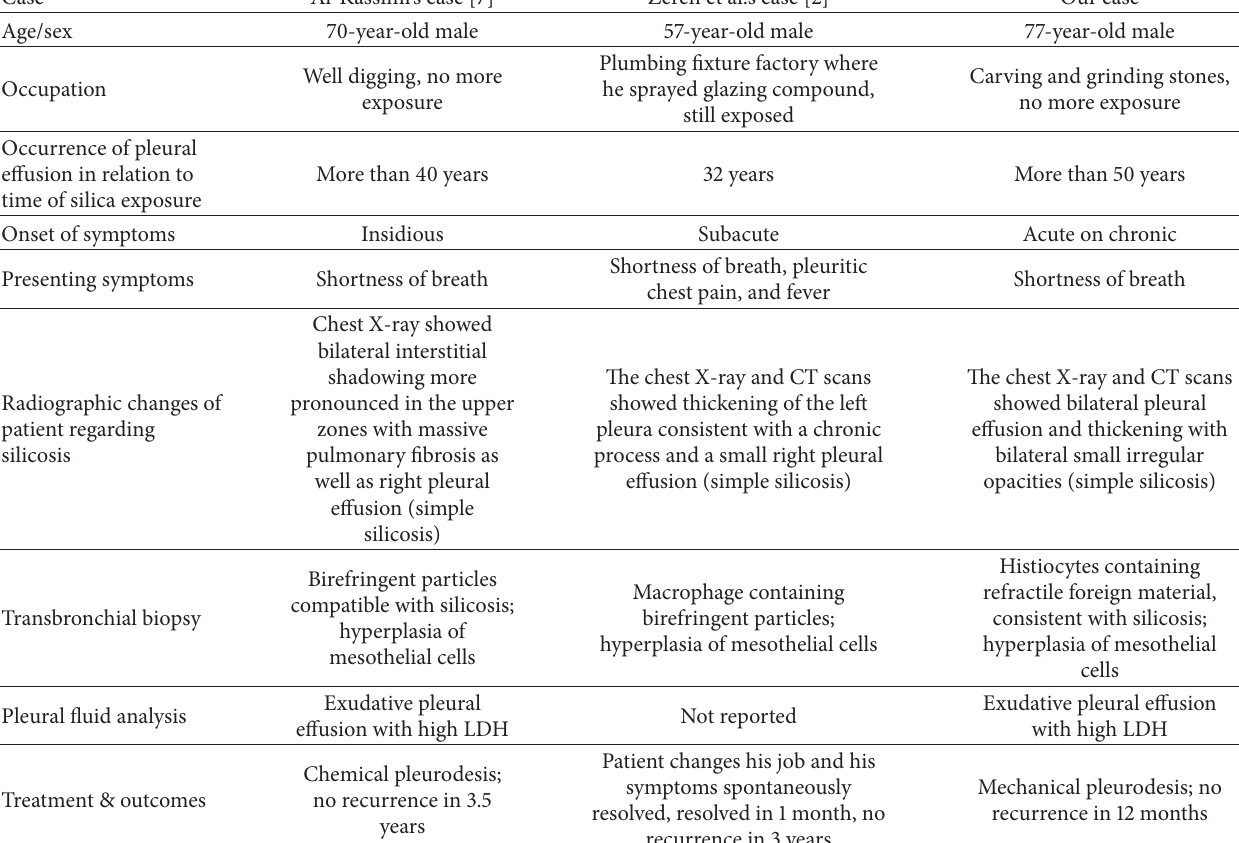
Table 1: Summary of the reported cases of silicosis presenting with pleural